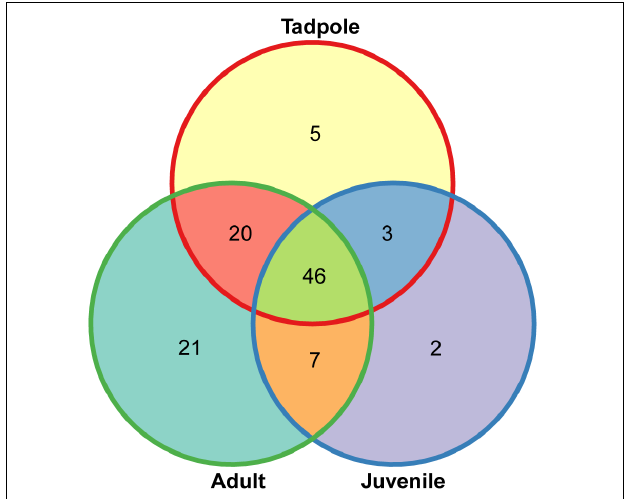
FIGURE 7 | Venn diagram of putative Bd -inhibitory ASVs across life stages of L. vibicarius .